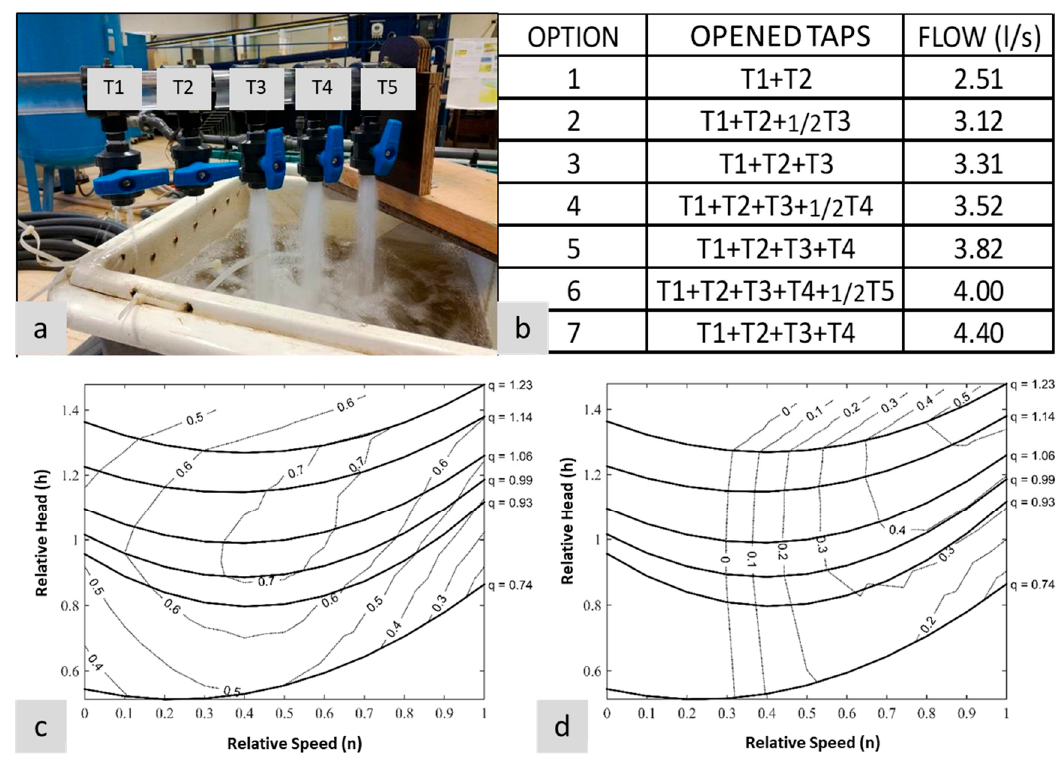
Figure 7. Experimental set-up of the selected hydrant: ( a ) view of the outlets from the hydrant prototype in the lab; ( b ) flow according to the selected option of the opened outlets; ( c ) PAT Operation graph (on-grid); ( d ) PAT Operation graph (PAT+SEIG).